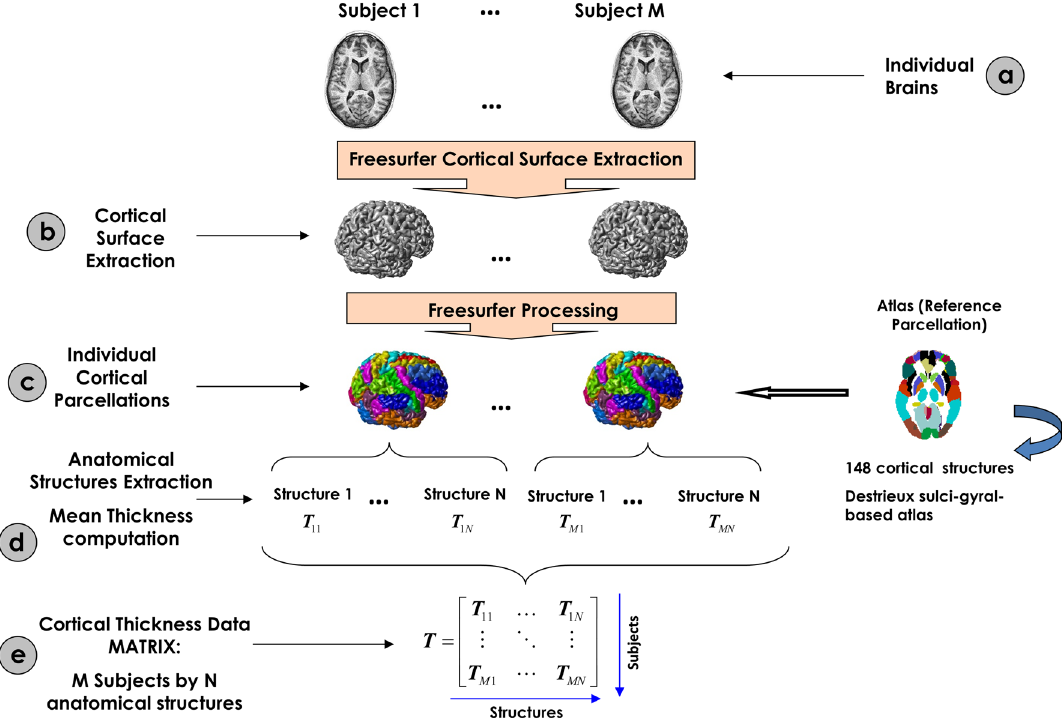
Figure 1. Flowchart of the cortical thickness matrix construction. ( a ) Representation of the M individual anatomic MRI images. ( b ) During FreeSurfer processing, the cortical surface of the M subjects was extracted. ( c ) Using the FreeSurfer toolbox, the cortical surfaces were labeled using a reference atlas. ( d ) The cortical thickness for each structure was calculated as the mean thickness of all vertices defined as belongs to that structure. ( e ) All mean thickness values for all structures and subjects were organized in an array denoted by T of M rows by N